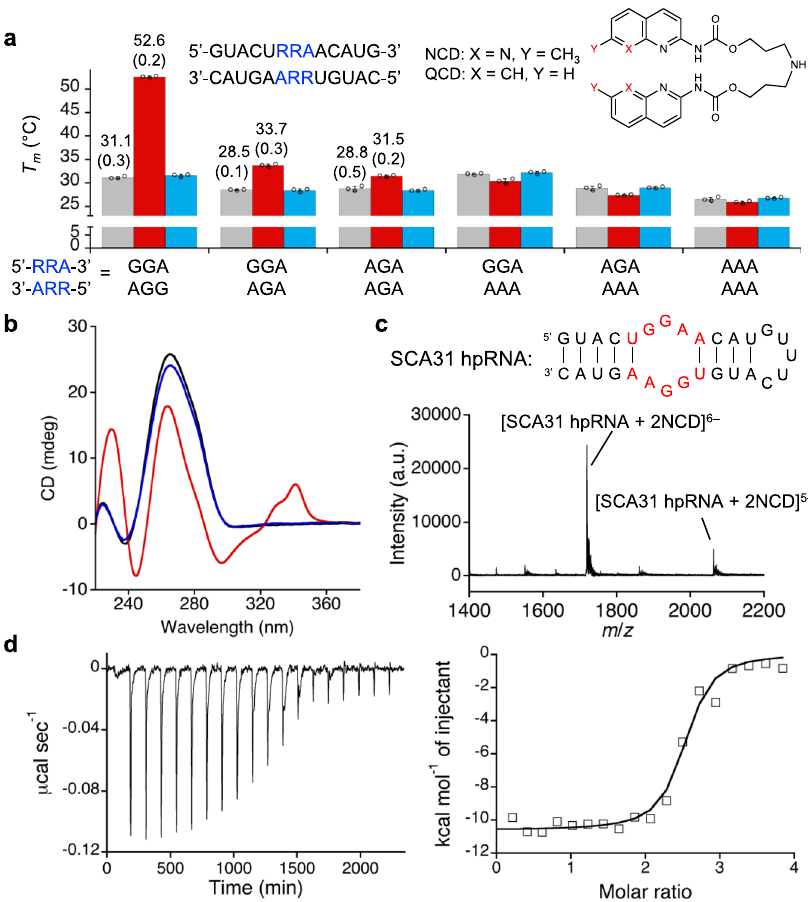
Fig. 2 Binding of NCD to UGGAA/UGGAA pentad-containing RNA. a Melting temperatures of RNA duplexes containing URRAA/URRAA pentad in the absence (gray) and presence of NCD (red) and QCD (blue). The data in T m measurements are presented as the mean ± SD ( n = 3 independent experiments). b CD spectra of RNA duplex containing UGGAA/UGGAA pentad (black) in the presence of NCD (red) and QCD (blue). c ESI-TOF-MS spectra of SCA31 hpRNA (10 μ M) in the presence of 40 μ M NCD. d ITC measurements for the binding of NCD to SCA31 hpRNA. Source data are provided as a Source Data fi